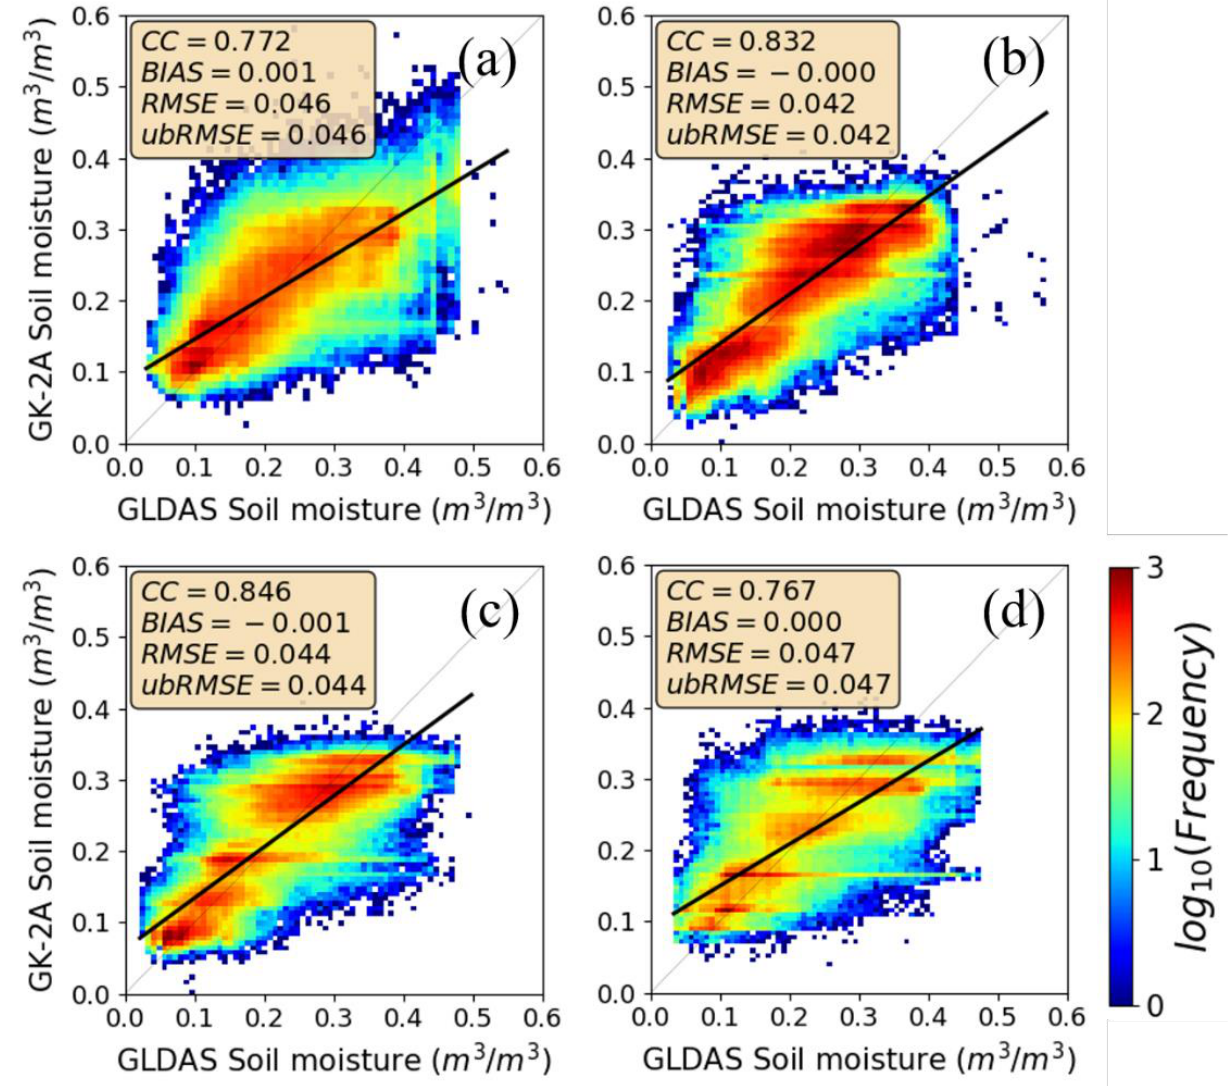
Figure 10. Scatterplots between GLDAS and GK-2A SM for the four seasons of ( a ) spring, ( b ) summer, ( c ) autumn, and ( d ) winter Table 6. Statistical comparison results between GLDAS and GK-2A SM.